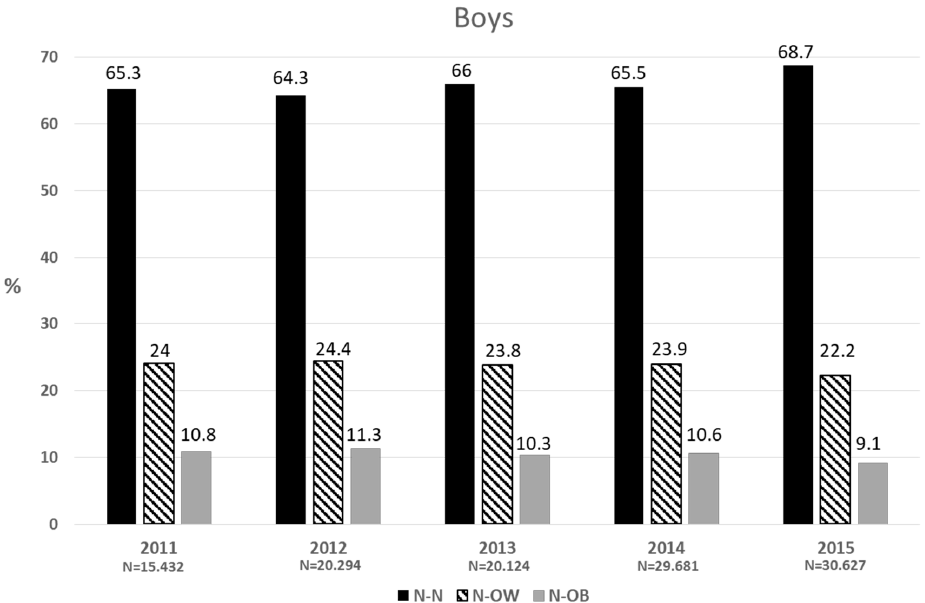
Figure 2. Two-year change (percentage) in the nutritional status of normal-weight prekindergarten children.